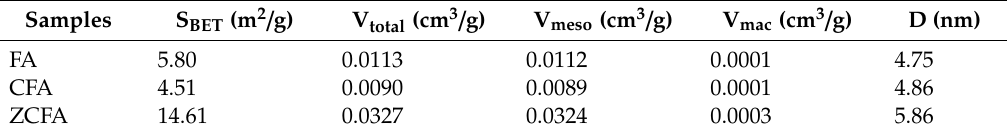
Table 1. Specific surface areas and pore characteristics of FA, CFA, and ZCFA